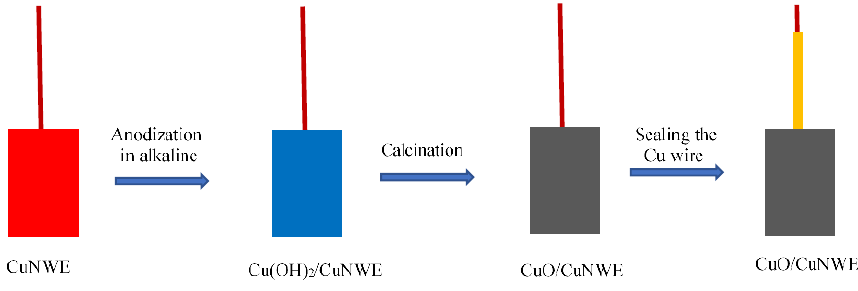
Figure 11. Schematic illustration for preparation of CuO/CuNWE.